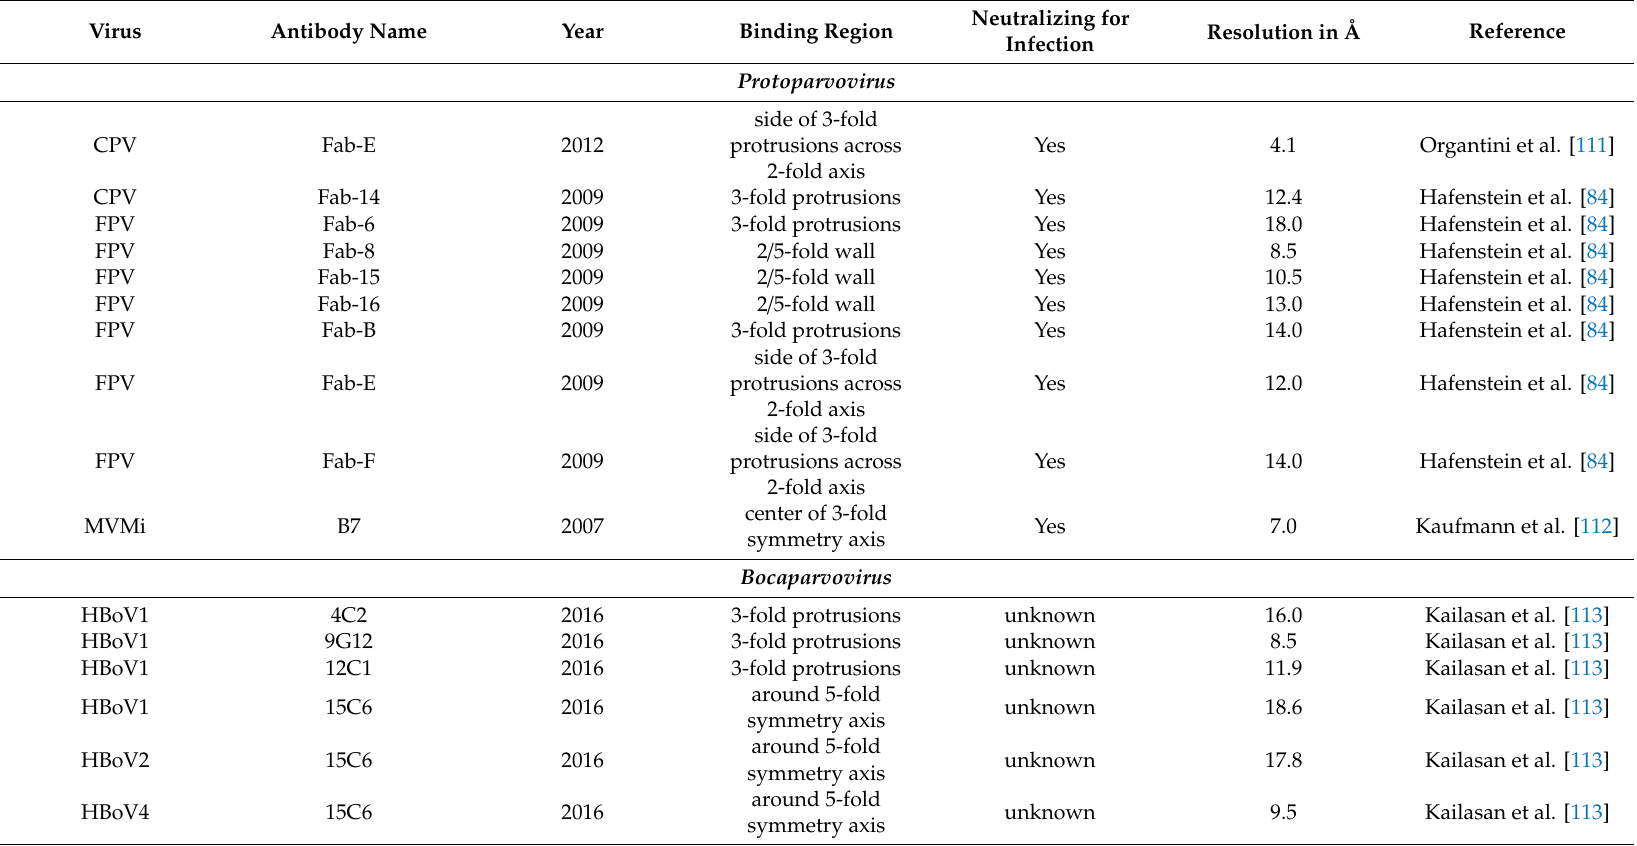
Table 4. Summary of published Parvovirinae capsid-antibody